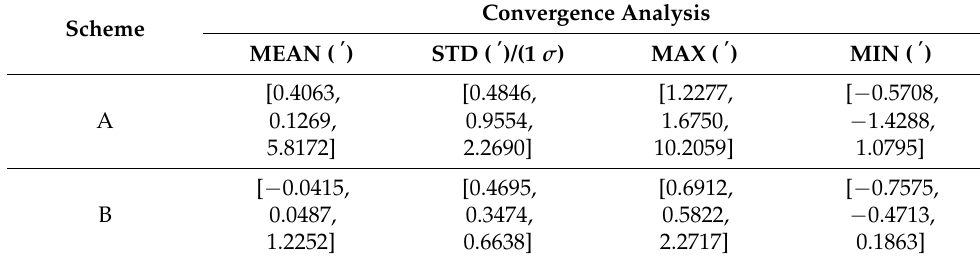
Table 4. Simulation